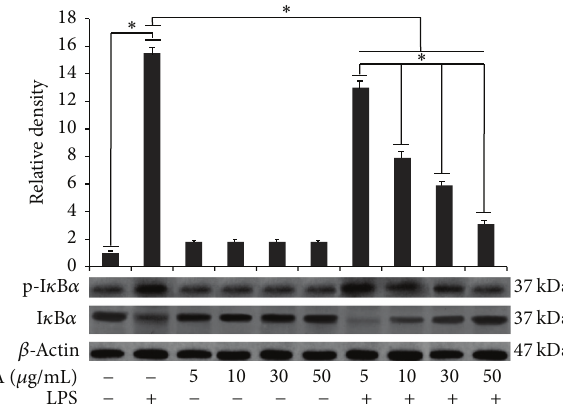
Figure 3: Effects of folic acid on the LPS-induced phosphorylation of I 𝜅 B 𝛼 . Cells were treated with the indicated doses of folic acid (5, 10, 30, and 50 𝜇 g/mL) for 1h before LPS (1 𝜇 g/mL) treatment for 12h. Total cell lysates were prepared for western blot analysis for the content of p-I 𝜅 B 𝛼 protein in BV-2 cells. Protein levels were determined by measuring immunoblot band intensities by scanning densitometry. Data represent the means ± S.D. of five separate experiments. ∗ 𝑝 < 0.05